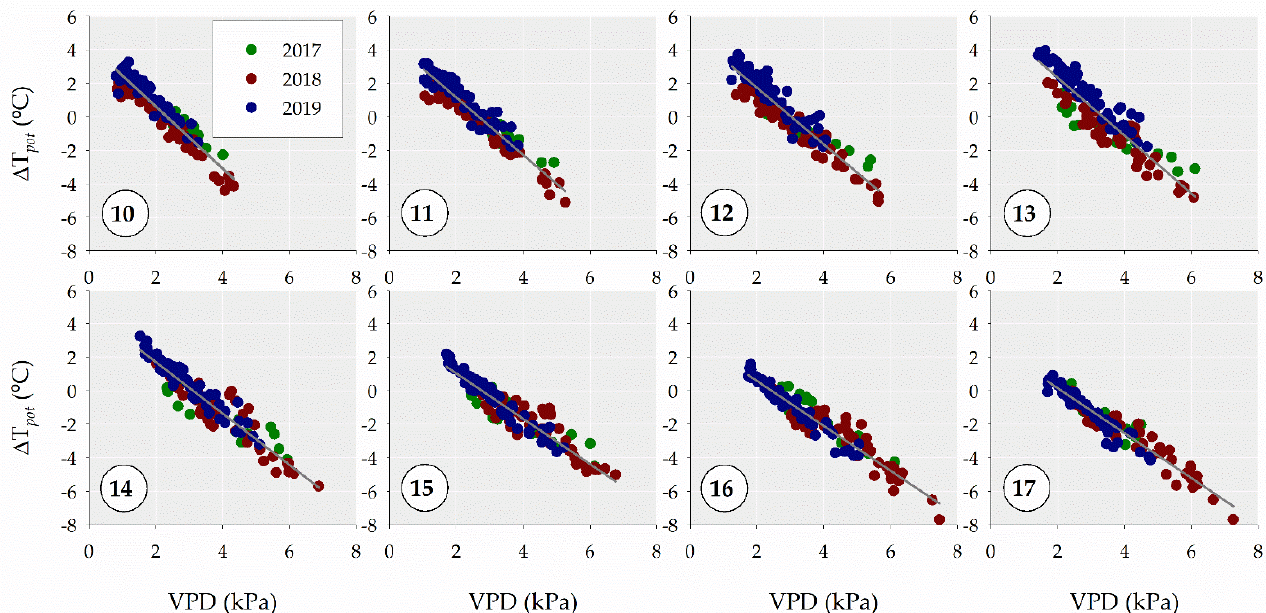
Figure 3. Relationship between hourly canopy-to-air temperature difference of well-watered maize plants ( ∆ T pot ) and vapor pressure deficit (VPD). Each panel depicts data of a single hour within the time interval 10–17 UTC; the number inside the circle within each panel indicates the UTM hour of that plot. Data from three growing seasons (2017, 2018, 2019) are pooled together. Each point represents a single maize breeding plot. The straight lines are the best-fit regression lines. Table 5. The fitted parameters and coefficients of determination (R 2 ) for the hourly non-water- stressed baselines ( Δ T pot = a pot + b pot ·VPD) are shown in Figure 3. Only clear-sky (cloudless) days of